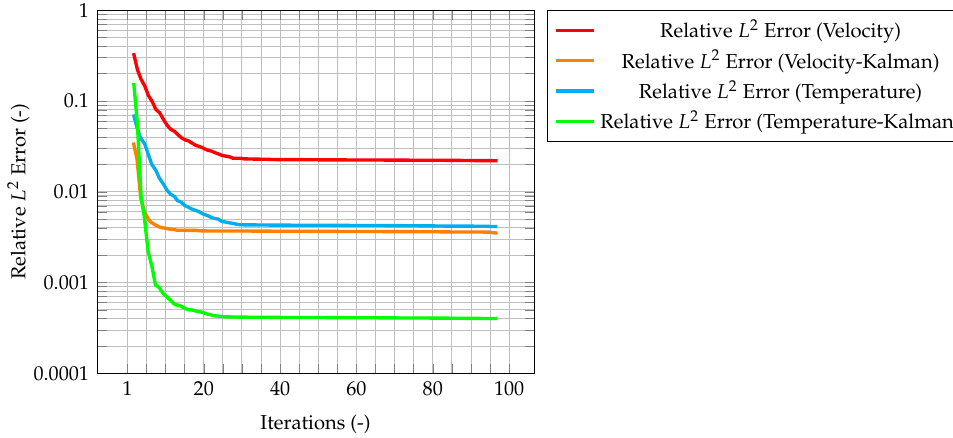
Figure 16. Normalized L 2 error for velocity and temperature. In the figures, the red and blue line represent the error evaluated between the reference solution and the one evaluated on a coarser grid without the correction provided by the filter, respectively, for velocity and temperature. In the case of the green line, temperature is now corrected by the Kalman filler, and thus velocity is computed starting from improved temperature values (however, the velocity itself is not corrected).